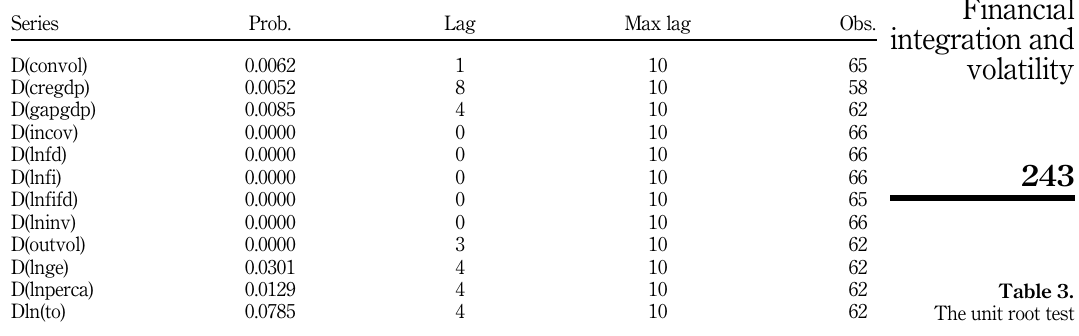
Table 3. The unit root test